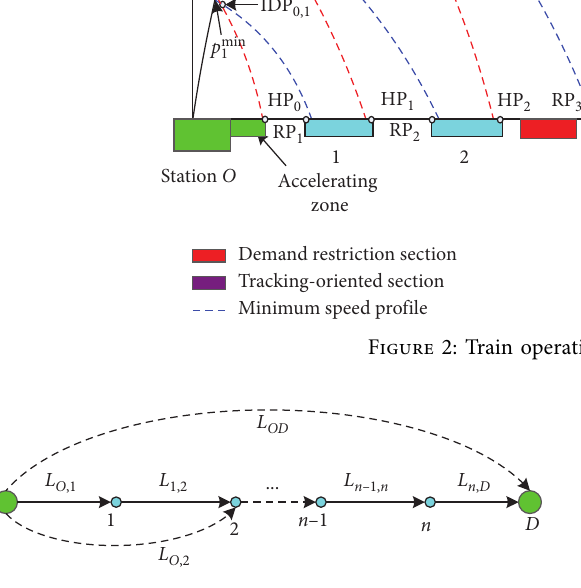
Figure 3: Analysis for the fewest cut